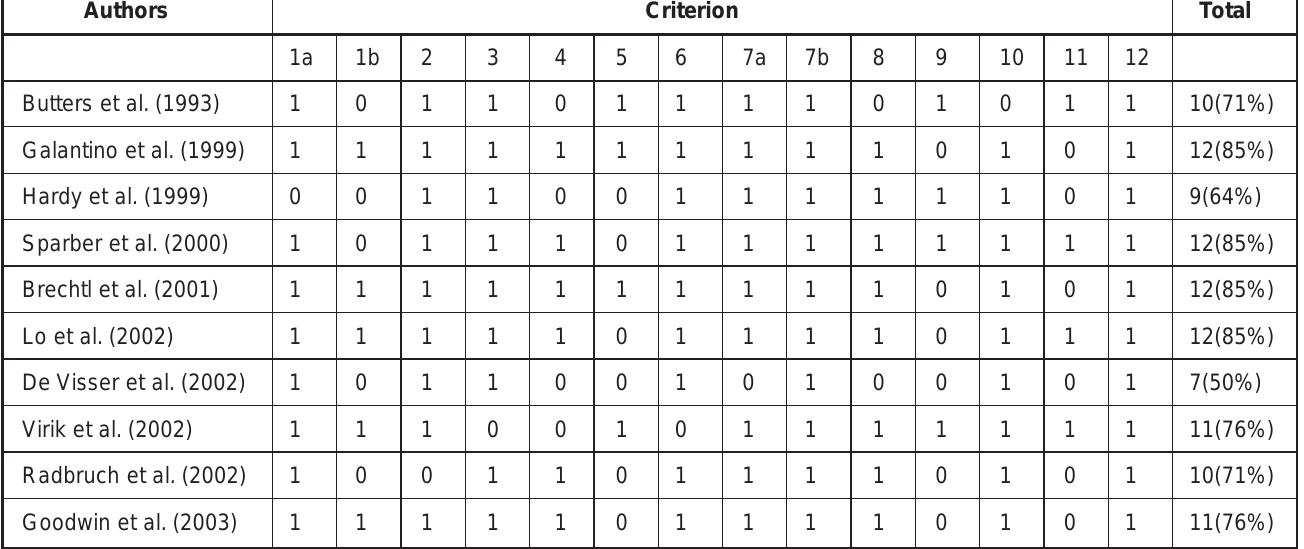
Table 6: Quality of Surveys.